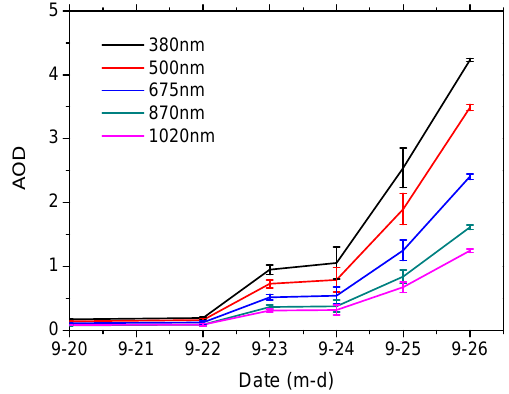
Fig. 3. Temporal series of daily averaged aerosol optical depth measured by sunphotometer in Beijing.